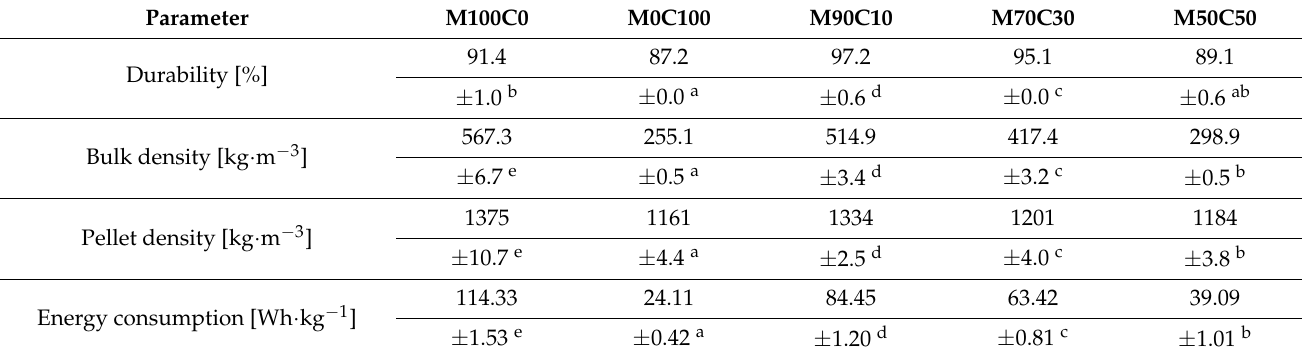
Table 2. Durability, bulk density, density of pellets, and energy consumption for pellets of various blends.